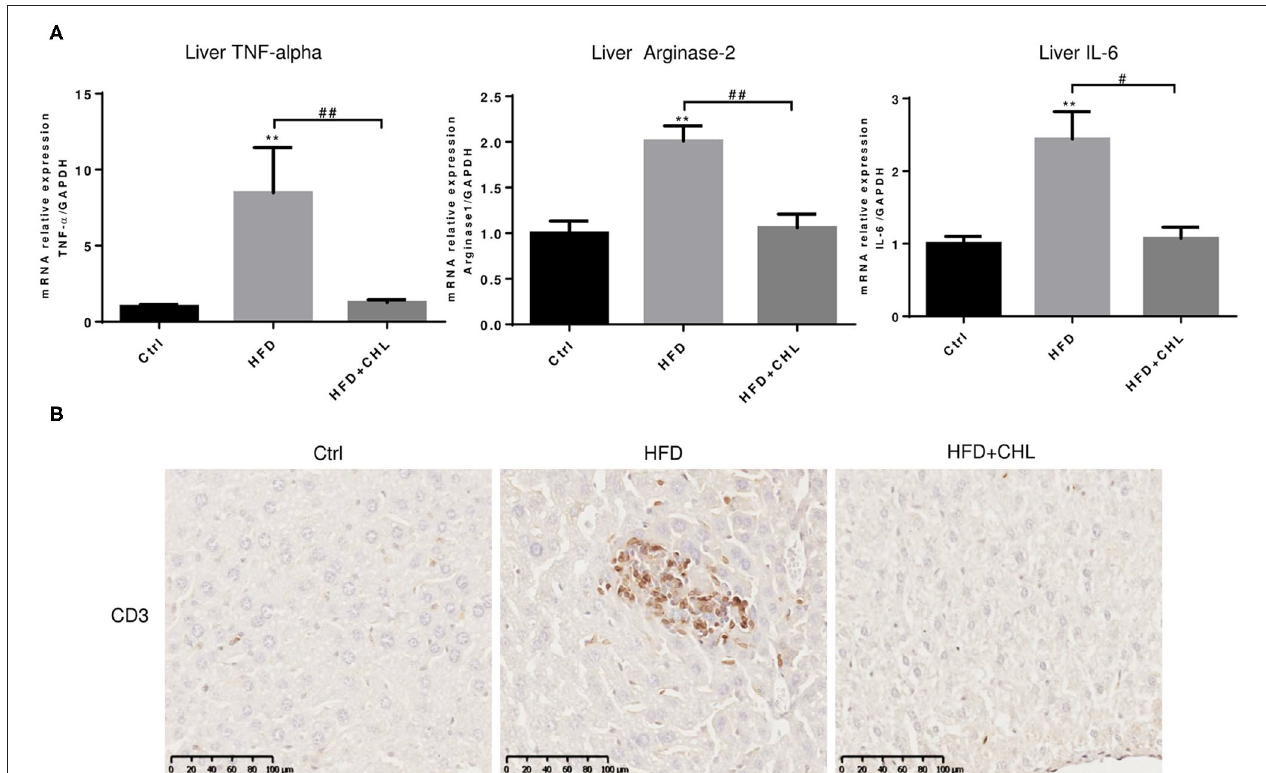
FIGURE 4 | CHL suppresses hepatic inflammation of the mice fed with an HFD. (A) The experimental condition is described in Figure 1 . In the end, the liver inflammation was measured by expression of tumor necrosis factor- α (TNF- α , Arginase-2, and Interleukin-6 (IL-6) by reverse transcription-quantitative real-time PCR RT-qPCR) analysis. (B) Infiltration of lymphocytes was monitored by immunohistochemical staining for CD3 + cells in the liver and n = 6–8 for each group. Values are mean ± SEM; ** p < 0.01 vs. Ctrl group; # p < 0.05, ## p < 0.01 vs, HFD group.